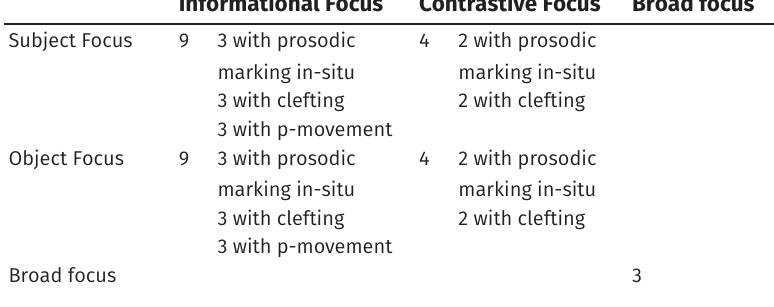
Table 1: Distribution of items across